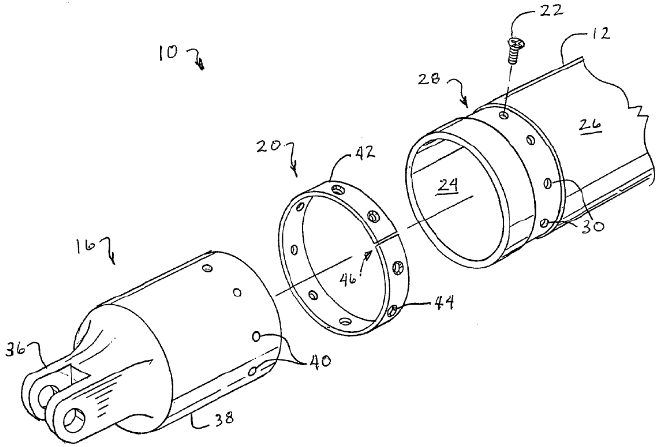
Figure 14. The method of connecting the cylinder and end cap by means of a split ring and screws [53].